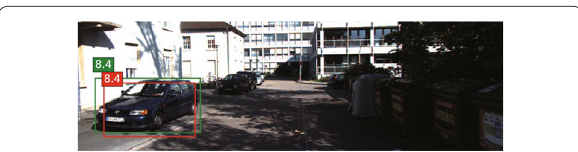
Fig. 2 Examples of the relation between the appearance of target objects (cars), and those distance in KITTI dataset. The green and red rectangles are the ground truth and estimated bounding boxes (by our proposed method) respectively. The values in green and red boxes are the GT and estimated distances respectively in a meter. The distance of the car on the left-hand side is 8.4 m